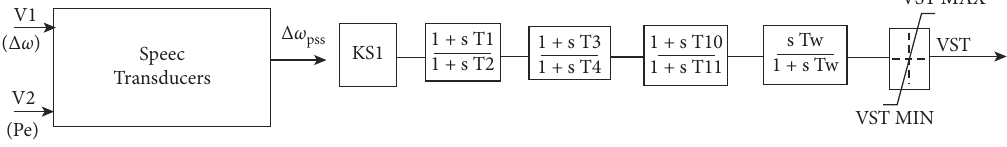
Figure 4: Block diagram of PSS2B stabilizer.